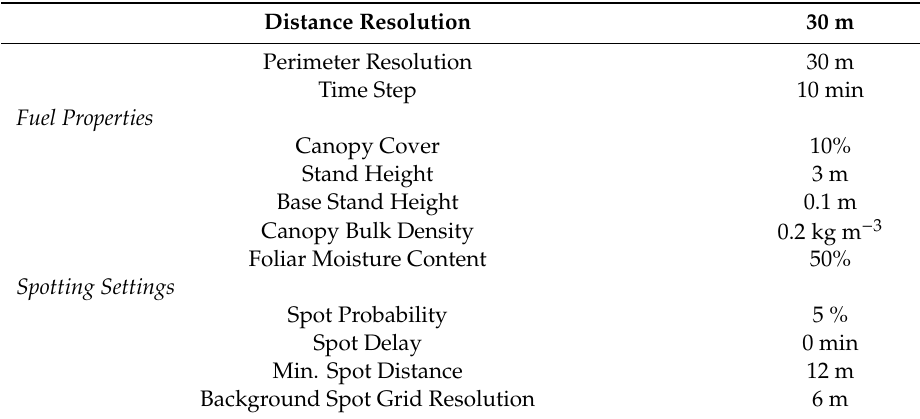
Figure 5. Sherpa fire ignition (blue dot), observed perimeters at 1600, 1700, 1800, and 1900 PDT (black polygons), and the simulated FARSITE burn areas (colored polygons) for simulations with ( a ) 1.0 GF, ( b ) 1.4 GF, and ( c ) 1.7 GF. Table 3. Specifications for both wildfire case study simulations.